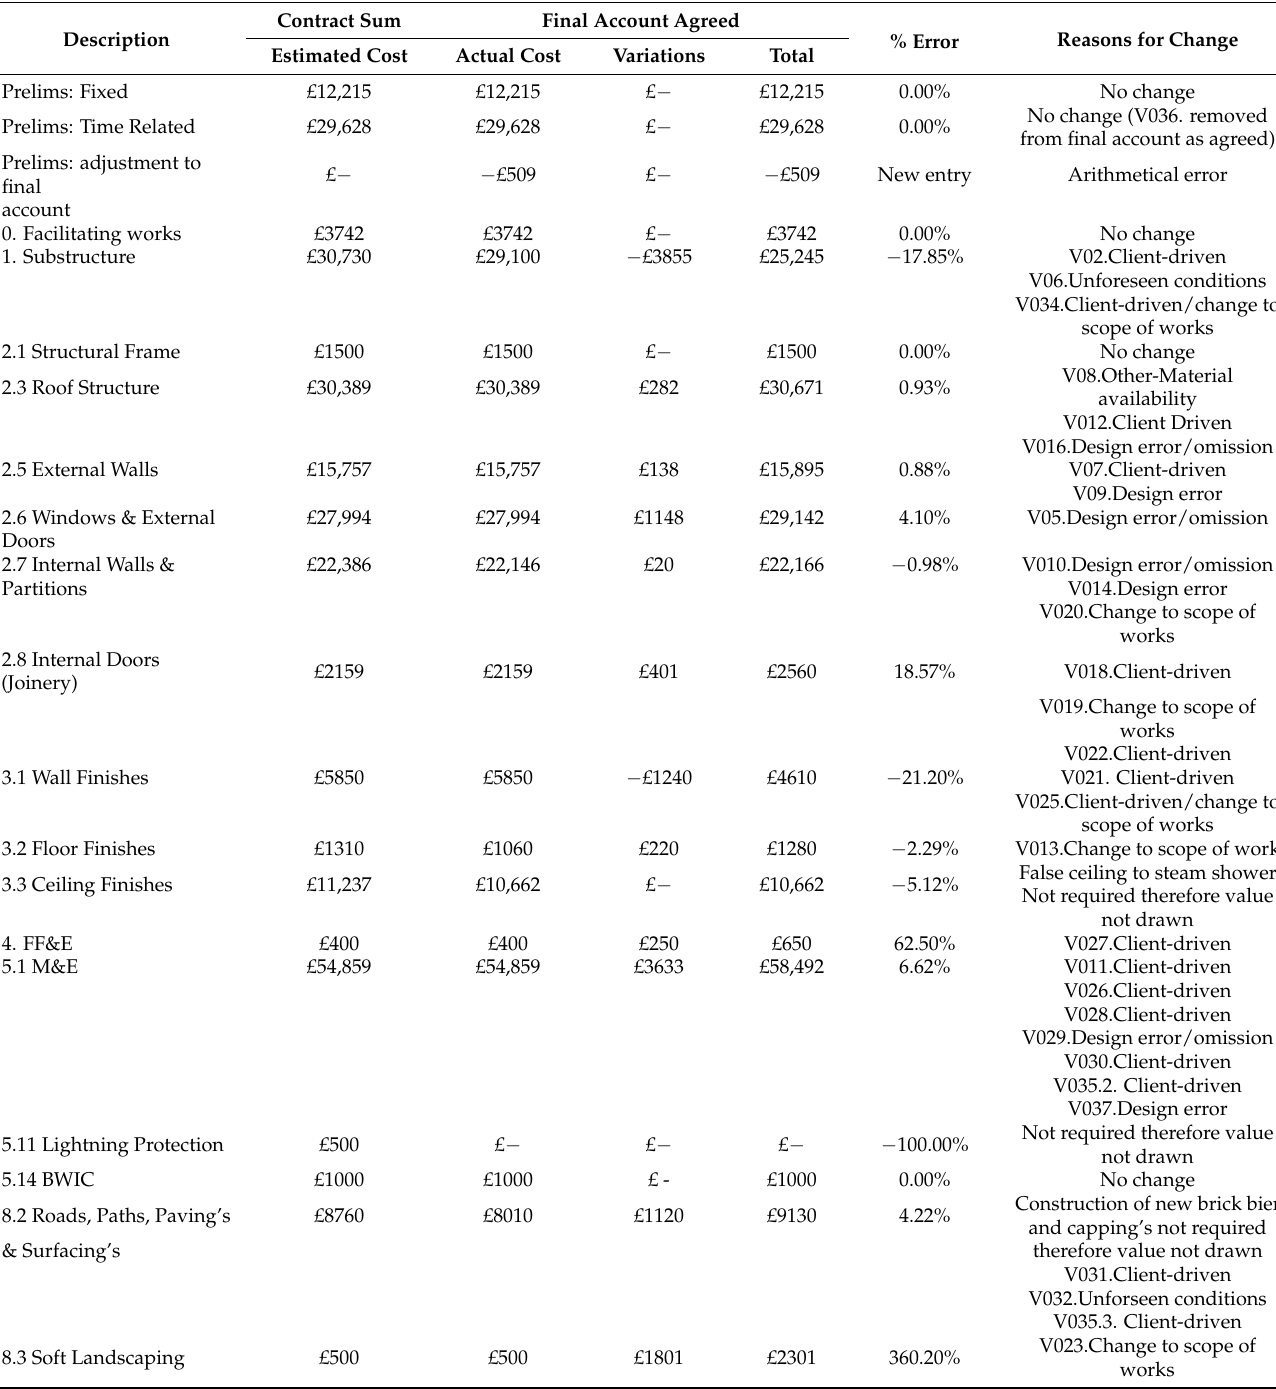
Table 6. Cross-sectional time horizon (excluding additional